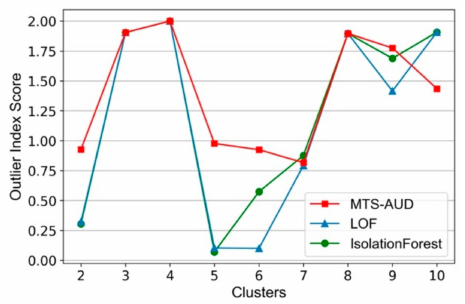
Figure 19. OutlierIndex score performance of three algorithms on each